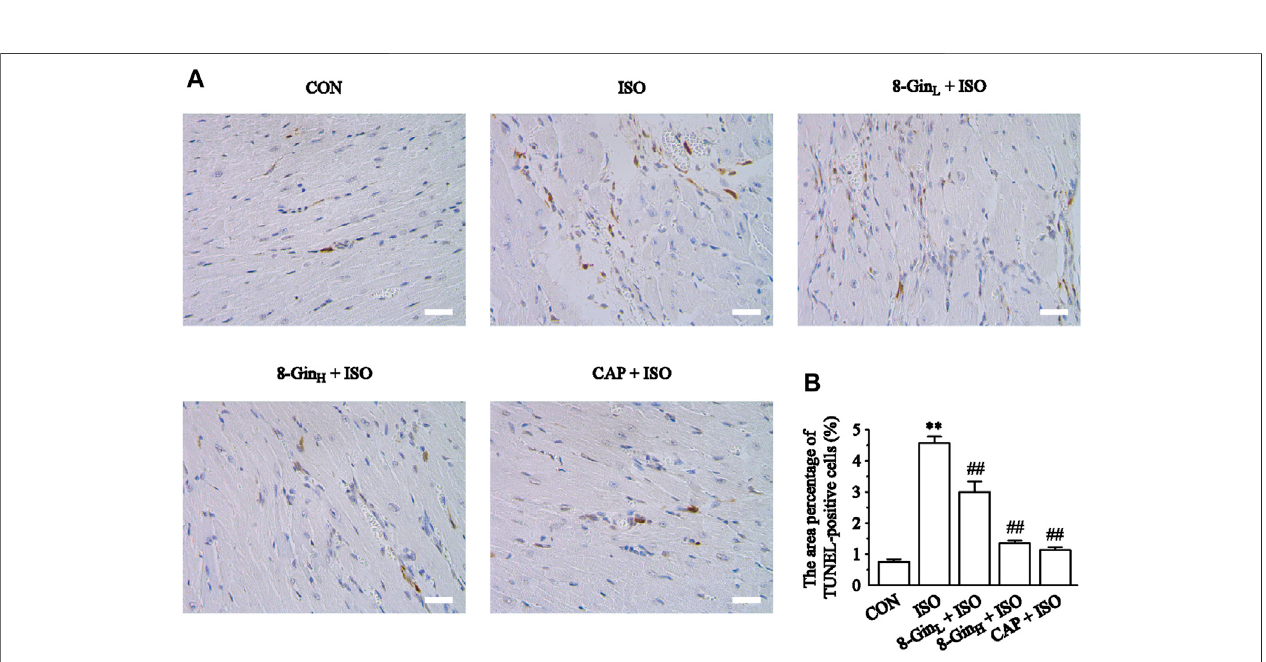
FIGURE 6 | Effects of 8-Gin on TUNEL staining. (A) Representative TUNEL staining of cardiac sections from each group (magni fi cation × 400, scale bar (cid:1) 50 μ m). (B) The area percentages of TUNEL-positive cells were shown. Data are shown as the mean ± SEM, n (cid:1) 5. ** p < 0.01 vs. the CON group; ## p < 0.01 vs. the ISO group.